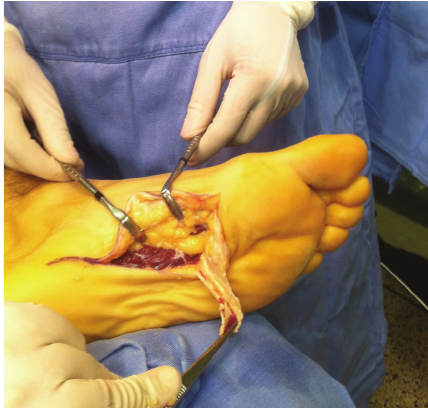
Figure 6: By reflecting the fascia distally, it was possible to protect the deep neurovascular structures.